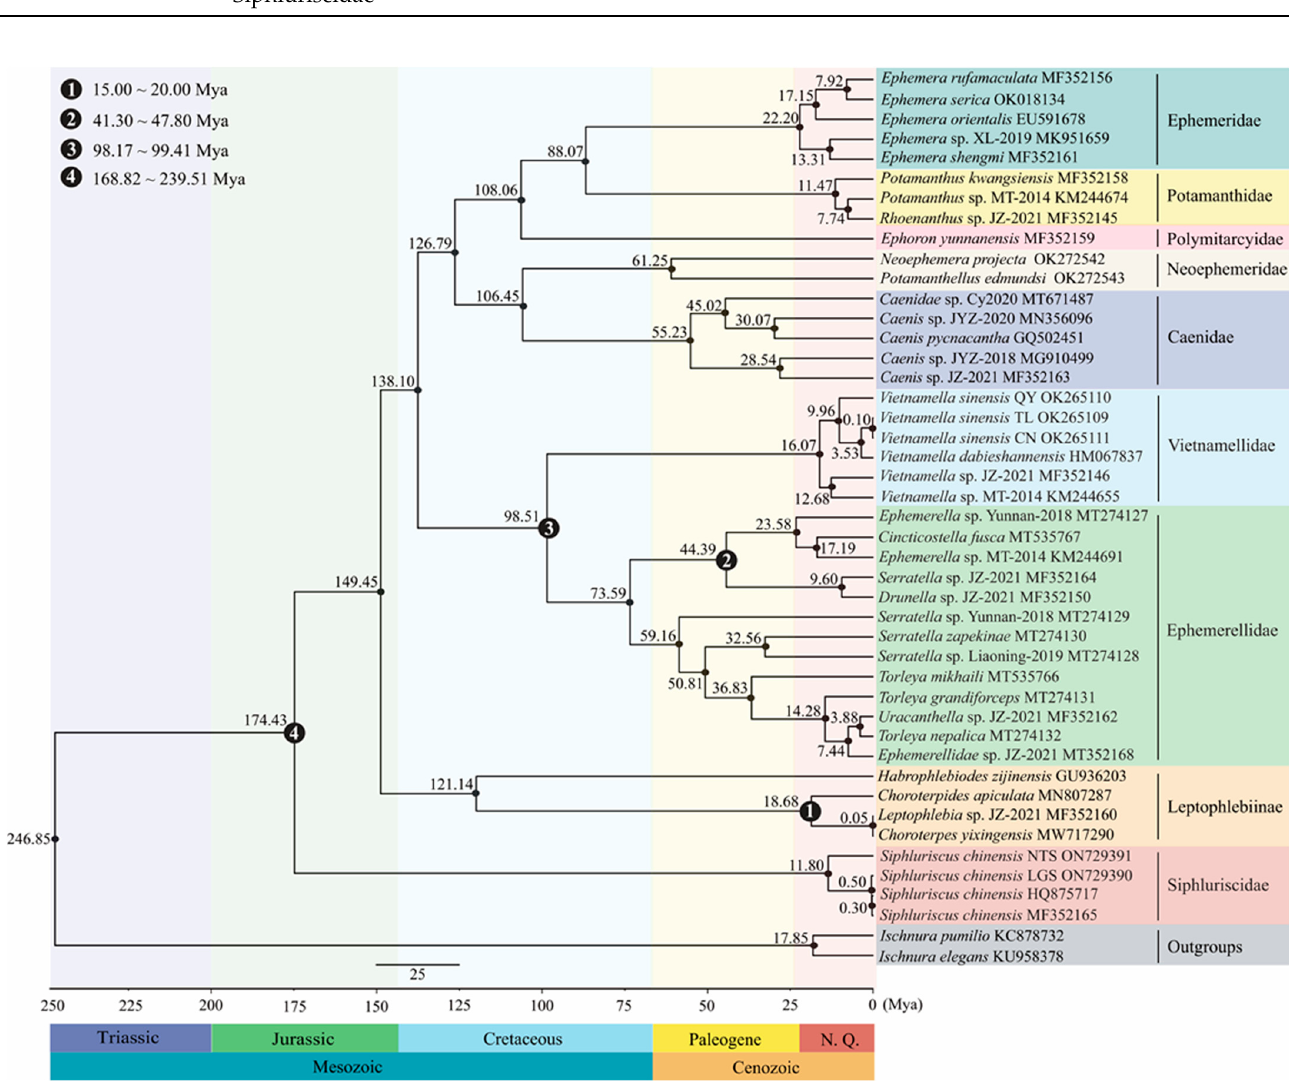
Figure 6. Evolutionary timescale within Ephemeroptera based on phylogenetic analyses. Median divergence times are provided above every node and the four fossil calibration points used are marked in the figure. The dates of each fossil calibration point are listed at the top left of the figure. The scale date is in million years ago (Mya) and the geological timescale is shown at the bottom of the chronogram. Table 3. Divergence times of nodes and clades within Ephemeroptera based on the mt genomes. All estimates are expressed as million years ago (Mya). The 95% highest posterior densities (HPD) are shown in the right column of the table. “&” represents the relationship between two branches.